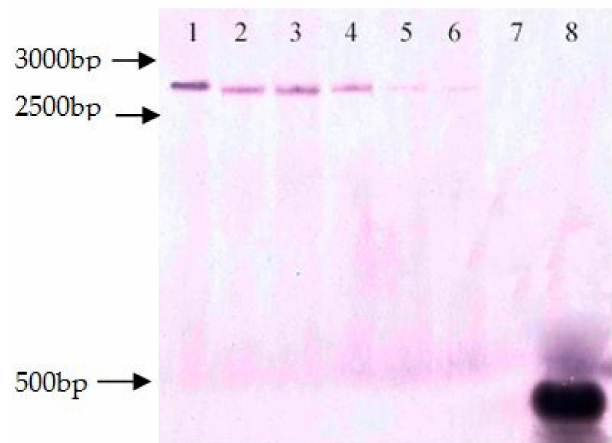
Figure 4. Southern-blot analyses of the gusA gene copy number in transgenic plants. 1: 22-2-2; 2: 44-3-1; 3: 64-2-1; 4: 64-3-1; 5: 98-3-2; and 6: 102-2-2; 7: hybrid aspen 353 as control; 8: pCaLFGmFNLFG